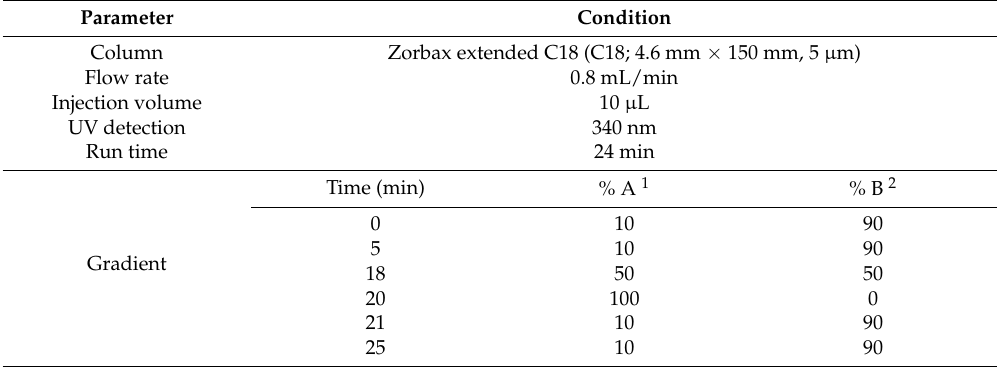
Table 6. Analytical conditions of high-performance liquid chromatography (HPLC) for analysis of the three